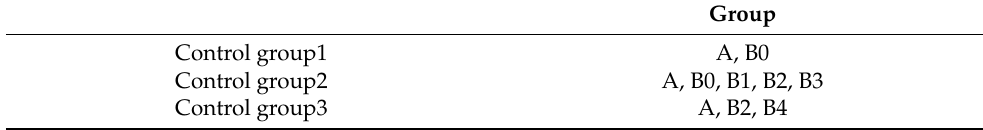
Table 6. Comparation strategy.